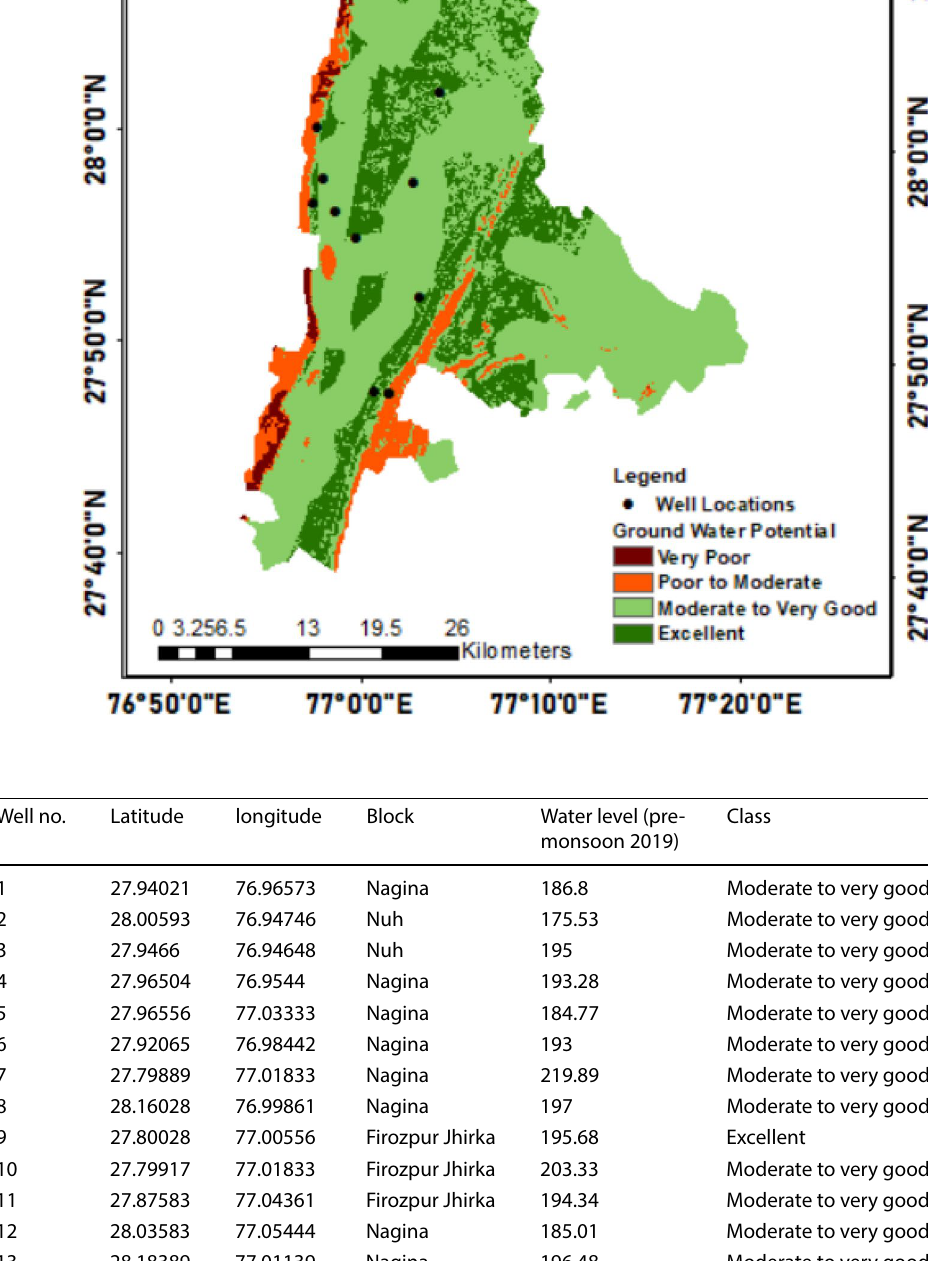
Fig. 17 Well location map with groundwater potential zones